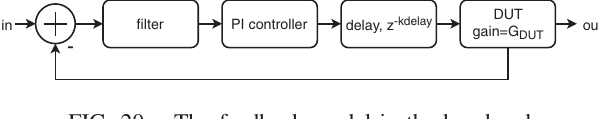
FIG. 20. The feedback model in the